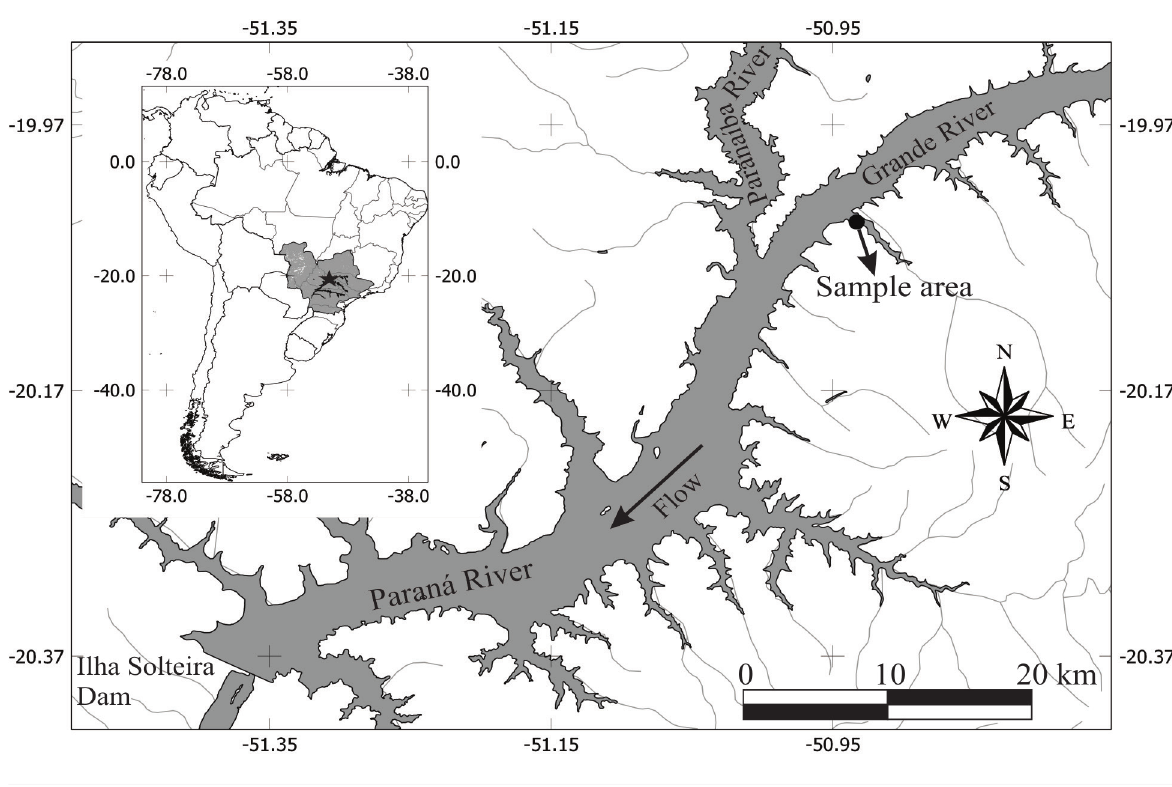
Figure 1. Study area on the Can-Can branch of the Ilha Solteira Reservoir, Grande River, São Paulo state,